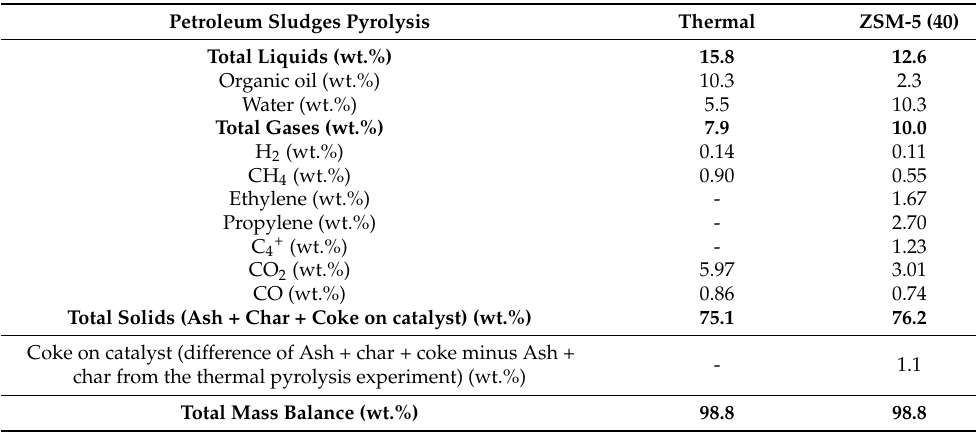
Table 4. Product yields in thermal and catalytic fast pyrolysis of petroleum containing sludge (NAS-1), at 600 ◦ C, obtained on fixed-bed reactor (C/F mass ratio =